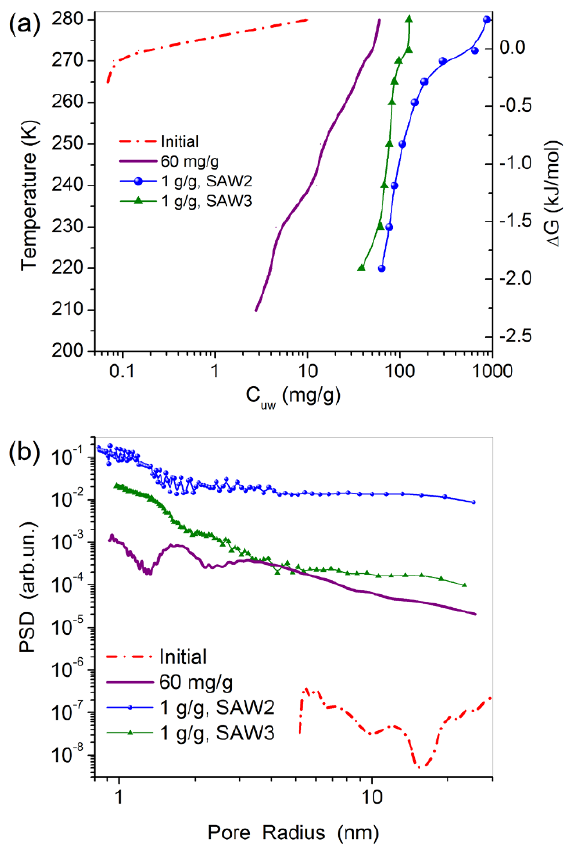
Figure 5. (a) Temperature dependences of the amounts of unfrozen water C ( T ) and the relationship between uw C and ∆ G for water bound to NC in chloroform-d uw medium at h = 10 (initial NC), 60 and 1000 mg g -1 ; at h = 1000 mg g -1 , curves for SAW2 and SAW3 are shown. (b) Size distribution of water structures or sizes of pores in NC filled by unfrozen